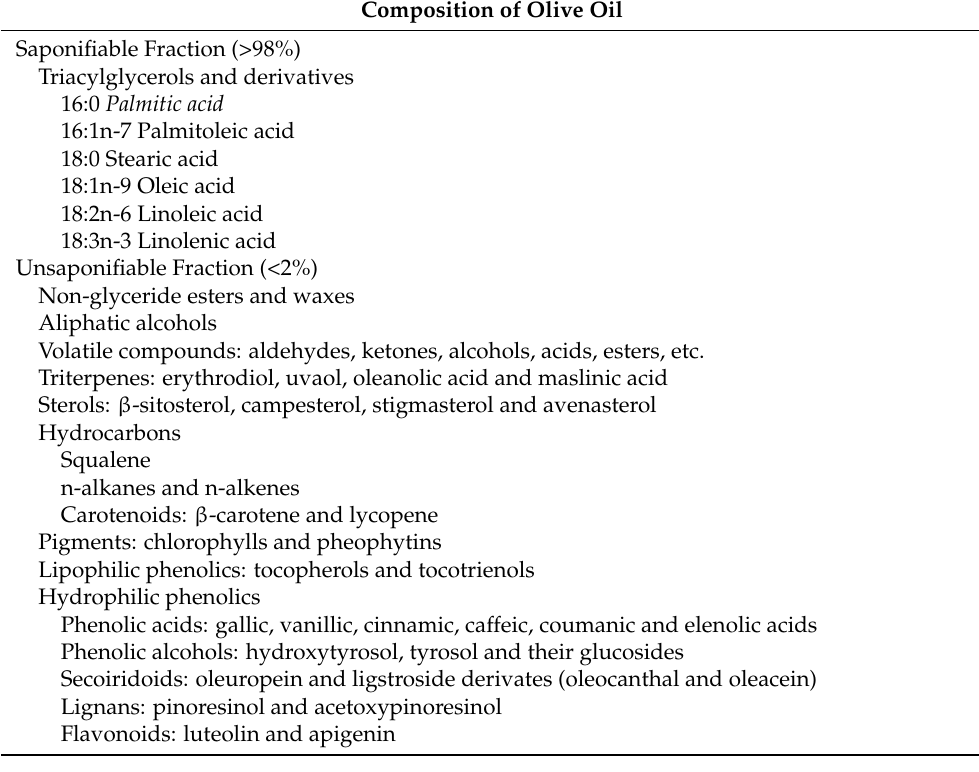
Composition of Olive